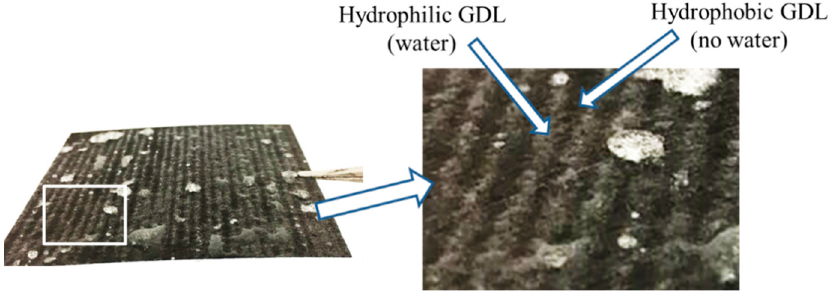
Figure 2. Water distribution on the hybrid GDL surface after immersion treatment.